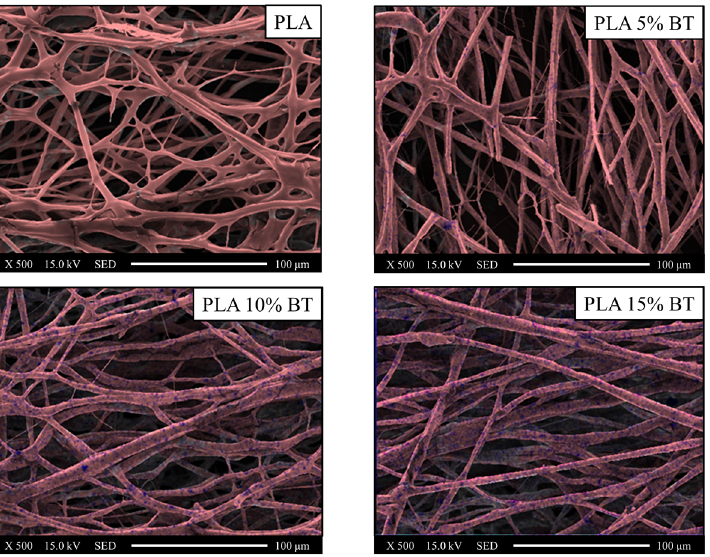
Figure 6. Images collected using EDX elemental maps of the PLA fibers and composites after ten minutes of UV/O 3 exposure and converted in two different colors (red for carbon and blue for barium) and overlaid on the SEM images in order to verify the incorporation of barium titanate inside the fibers and the distribution. EDX and SEM images were collected at 500 × magnification.